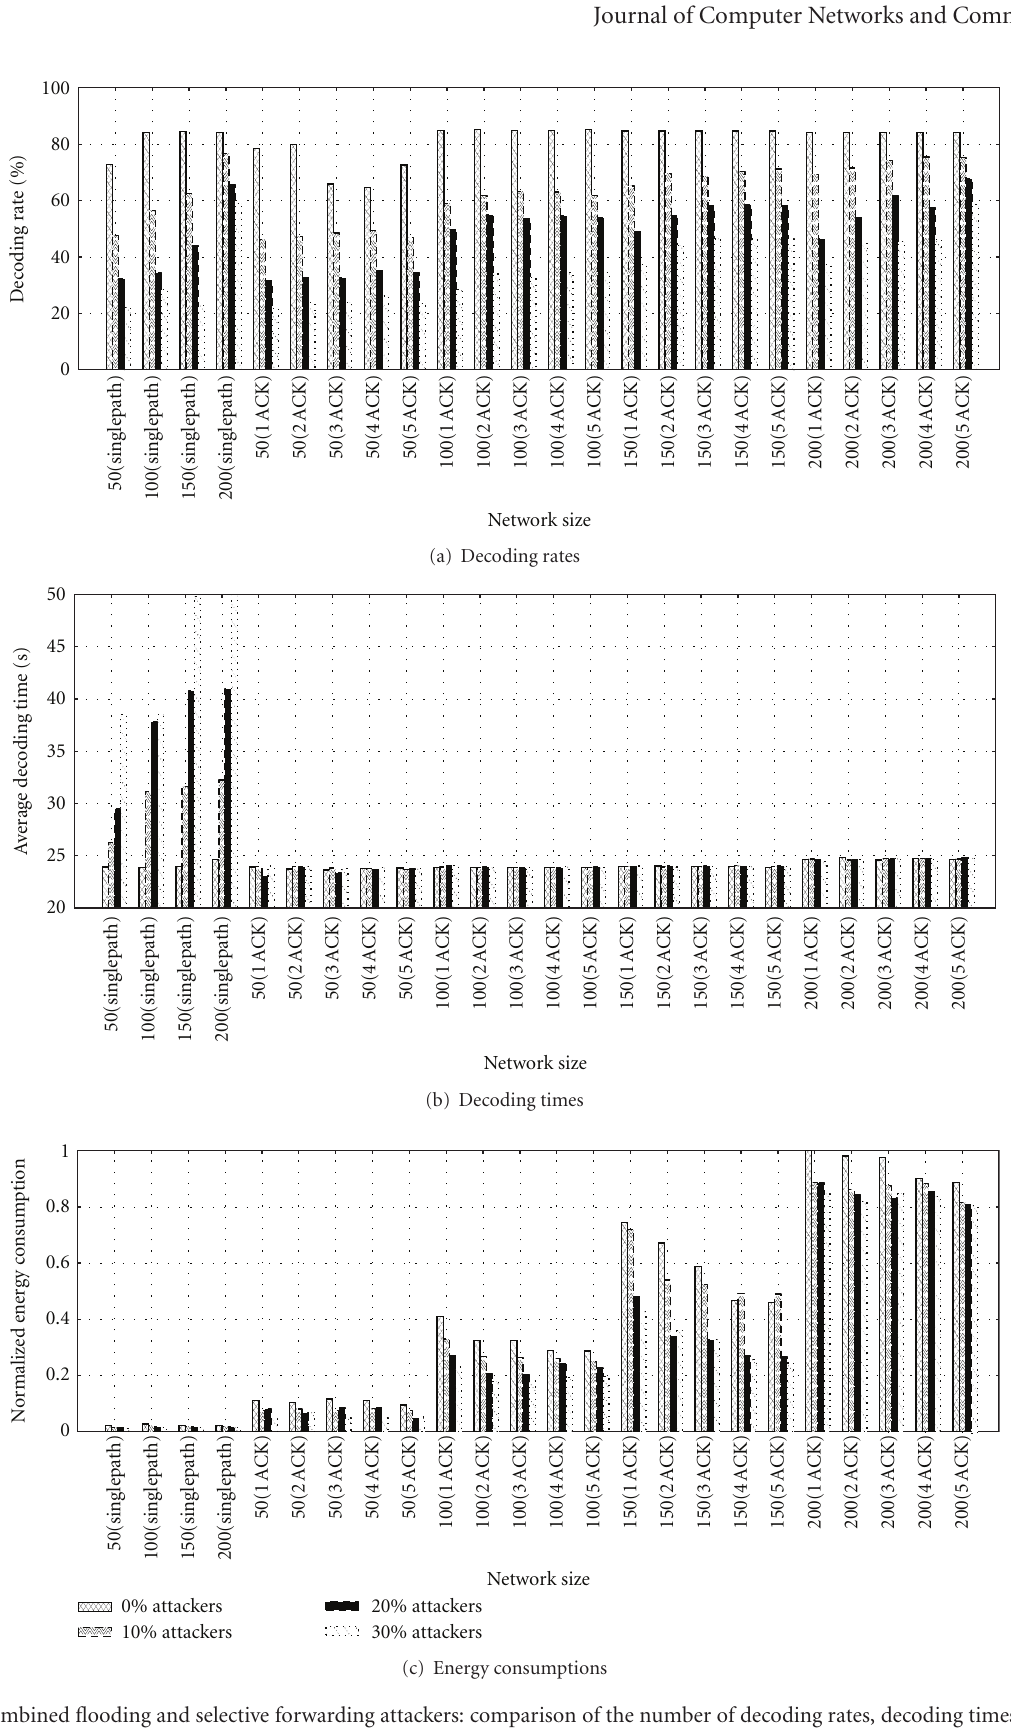
Figure 8: Combined flooding and selective forwarding attackers: comparison of the number of decoding rates, decoding times, and energy consumptions in case of 1 ACK path, 2 ACK paths, 3 ACK paths, 4 ACK paths, and 5 ACK